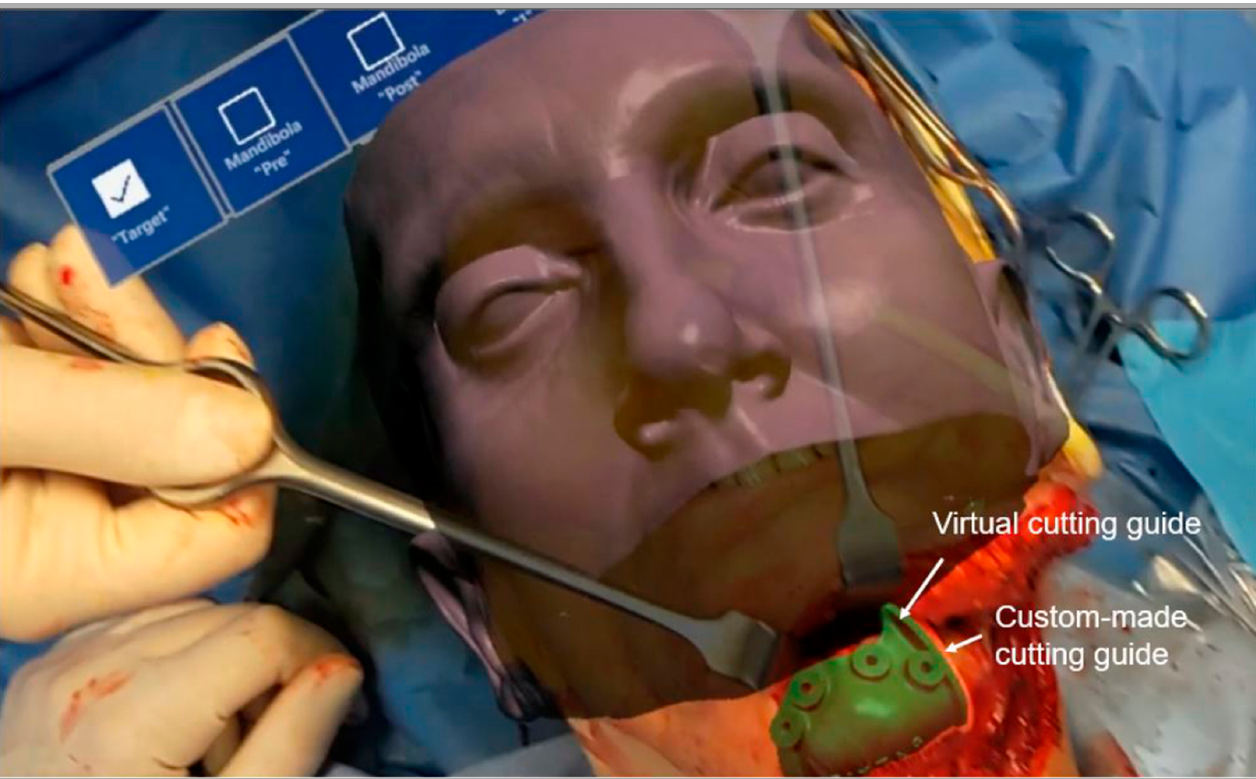
Figure 7. Screenshot of the operative field taken using the HoloLens camera when both the corticotomy line was projected in AR and the cutting guide was positioned on the patient.